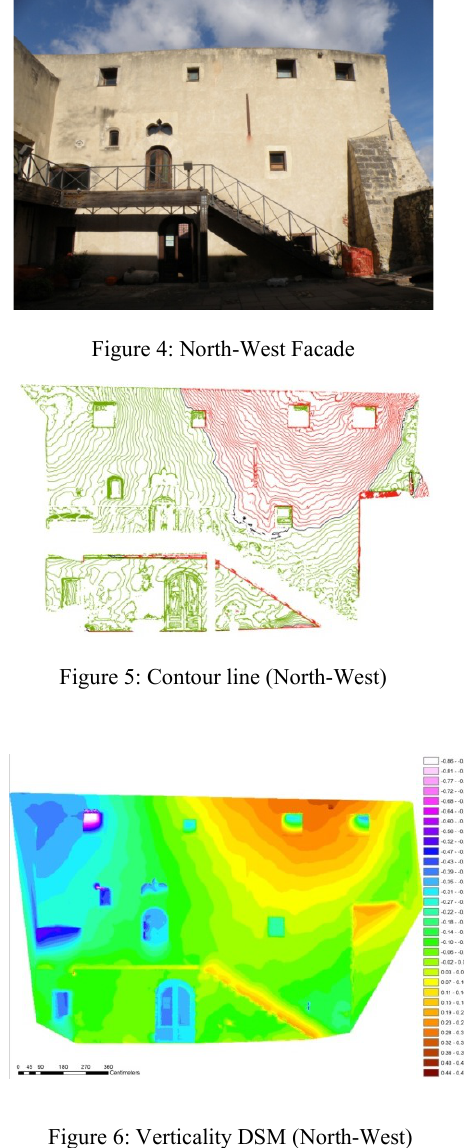
Figure 6: Verticality DSM